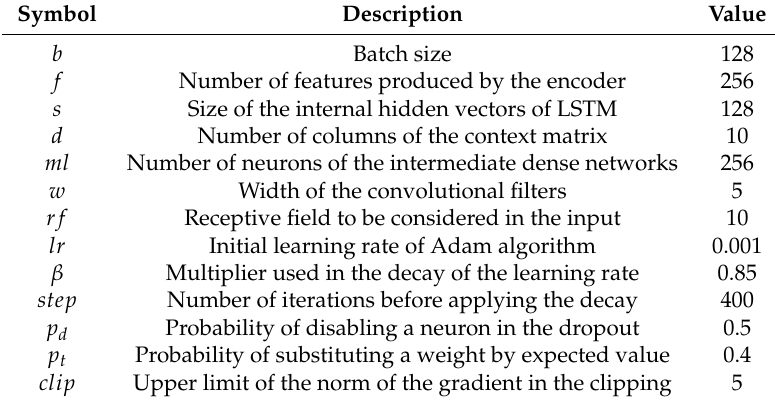
Probability of disabling a neuron in the dropout 0.5 Probability of substituting a weight by expected value 0.4